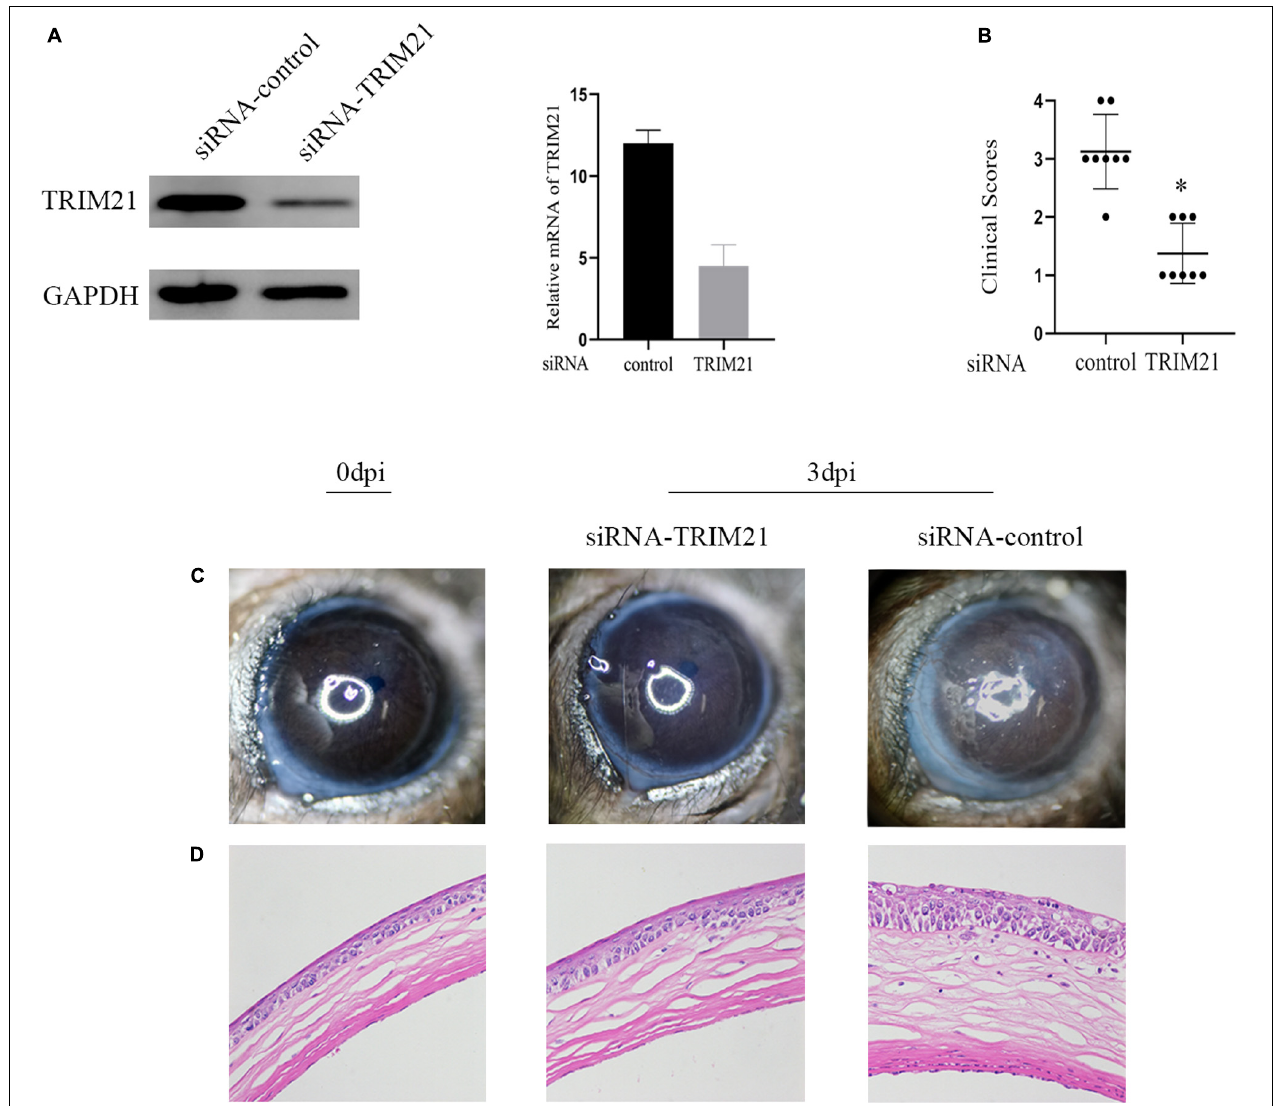
FIGURE 2 | Silencing TRIM21 alleviates the severity of HSV epithelial keratitis. (A) The protein (left) and mRNA (right) levels of TRIM21 in corneas were assessed to confirm the transfection efficiency of siRNA before establishing HSV epithelial keratitis models. (B) HSV epithelial keratitis clinical scores at 3 dpi. n = 8 per time point. (C) Representative photographs of corneas from each group of mice at 3 dpi corresponding to (D) histopathology results. Magnification: 400 ×